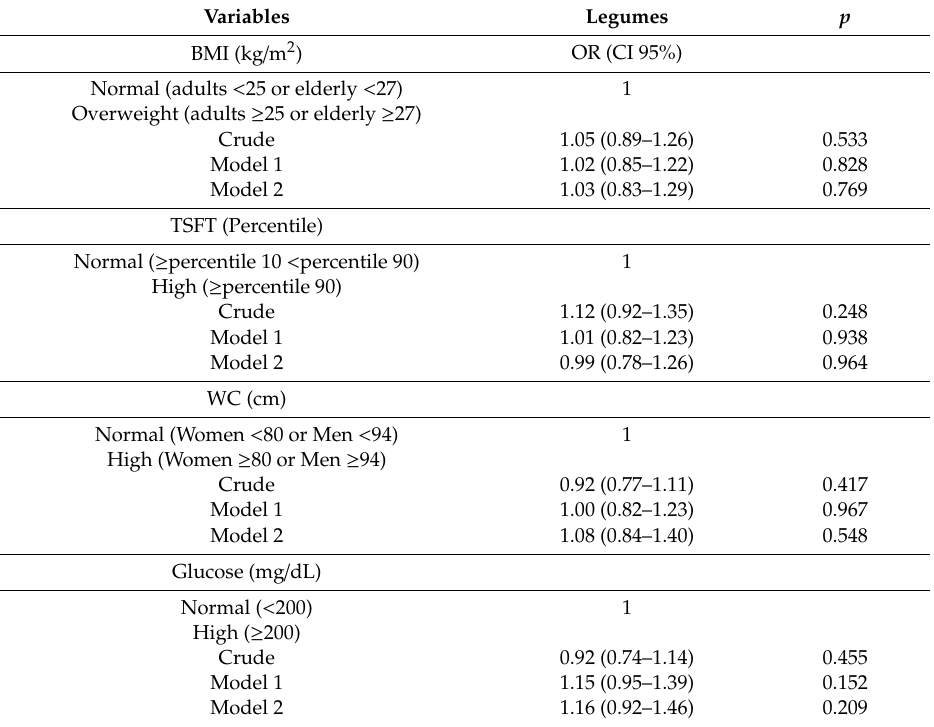
Table 2. Association (Odds ratio) between ingestion of legumes with anthropometric measurements and blood glucose concentrations.